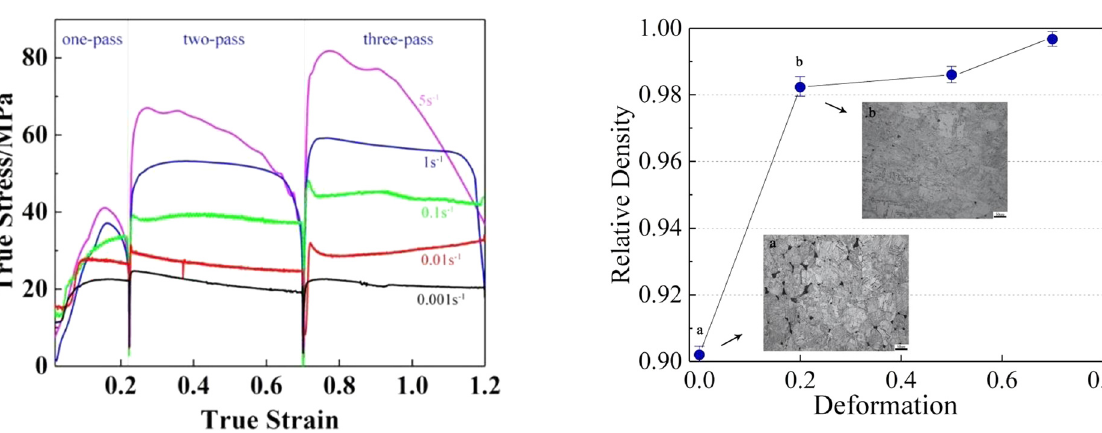
Figure 2: True stress – true strain curve of the TC4 titanium alloy. Figure 2, the curve re fl ected some changes in the